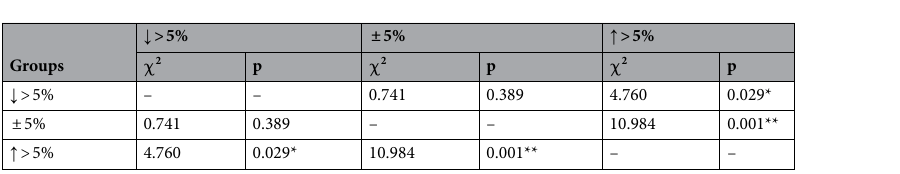
Table 5. Breslow pairwise comparisons of survival distributions by EF trend (n = 936). *; **; ***Statistically significant differences (p < 0.05; p < 0.01; p < 0.001).